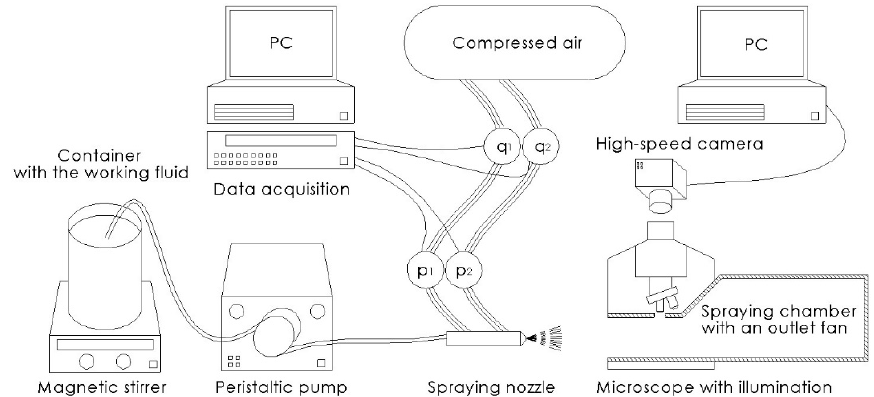
Figure 1. Experimental setup for measuring droplet